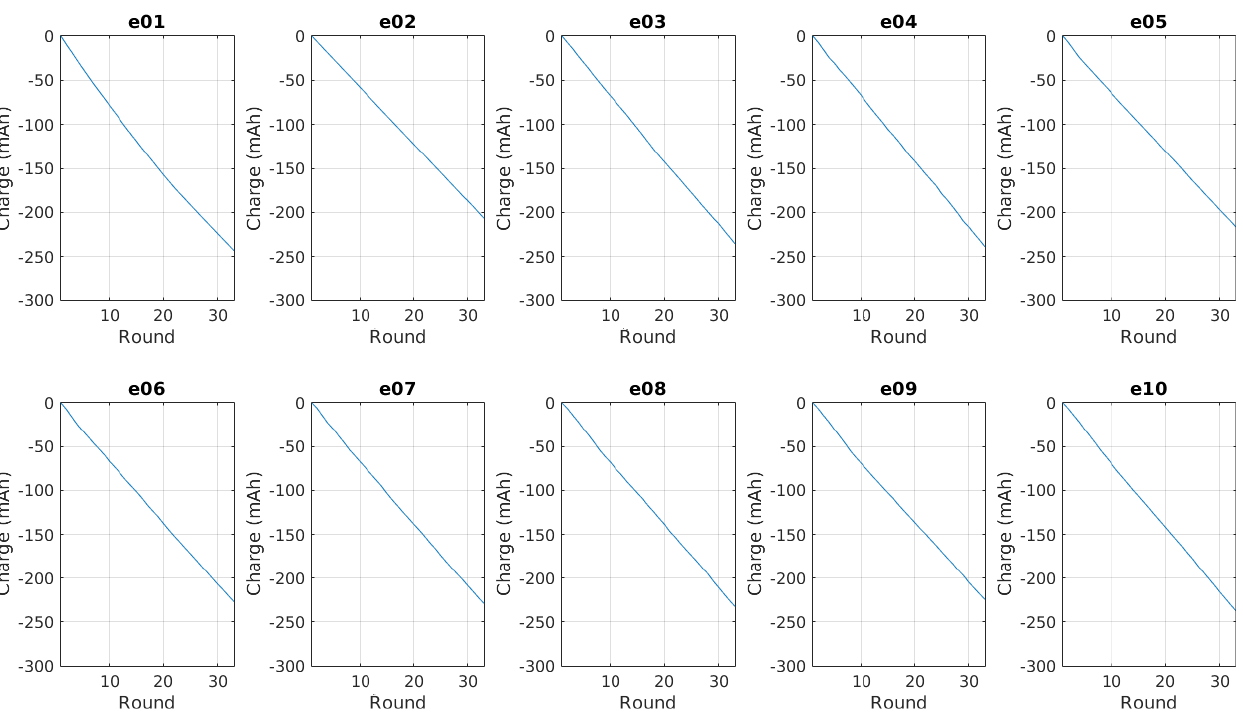
Figure 7. Evolution of the total charge per experiment, relative to the first value of each